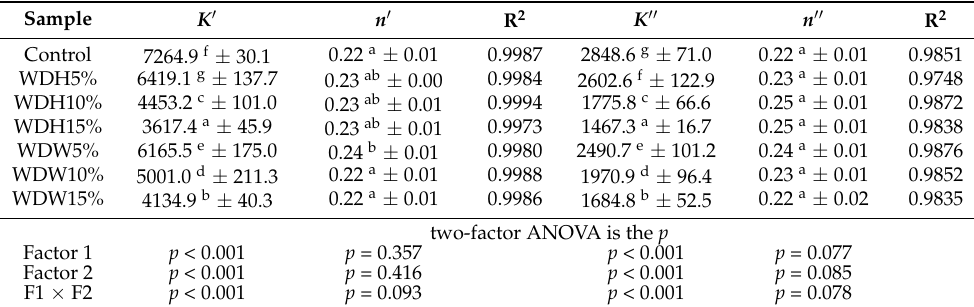
Table 4. Parameters of the power law equations describing the viscoelastic properties (25 ◦ C) of wheat dough with nut